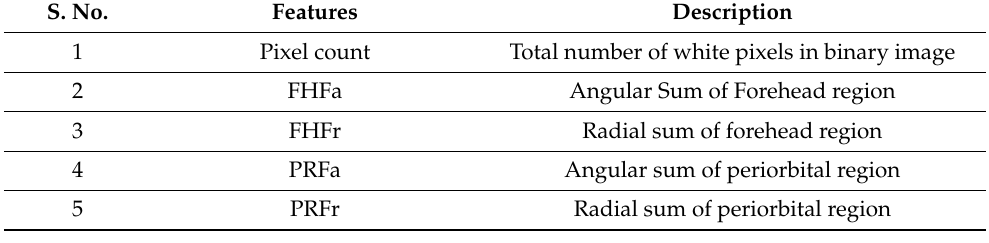
Table 2. List of features from the thermal image. S. No.